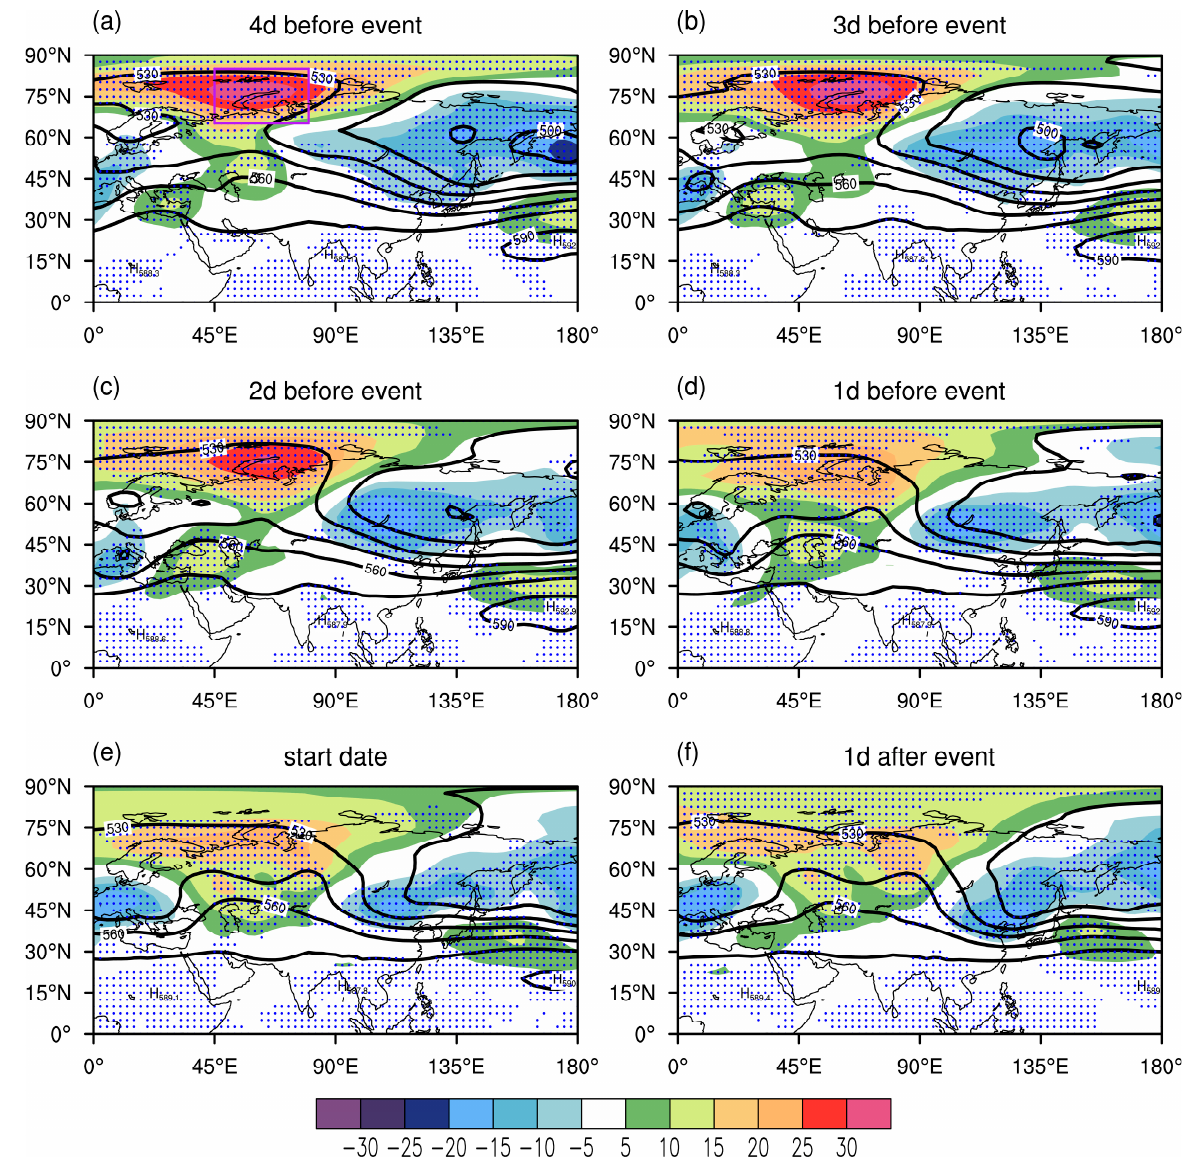
Figure 3. The composites of mean potential height (500 hPa, shown in contours) and anomaly (shaded, unit: dagpm) for the three cold wave events. The events are labeled as “1228”, “0105”, and “0114”, respectively, with their start dates marked. ( a – f ) Represent the four days prior to, three days prior to, two days prior to, one day prior to, the same day as, and one day after the start date, respectively. The dotted area indicates anomalies with the same sign among the three cold wave events. The purple box highlights the key area of blocking high, which is located between 45° N and 80° N, and 65° E and 85° E.